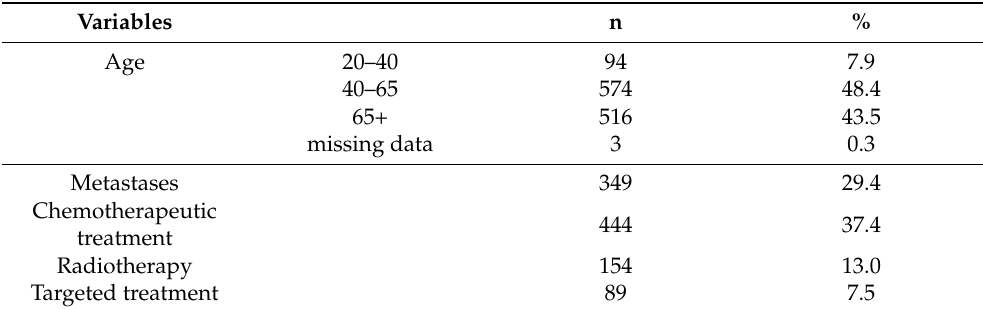
Table 2. Age distribution and indicators of the advancement of the neoplastic